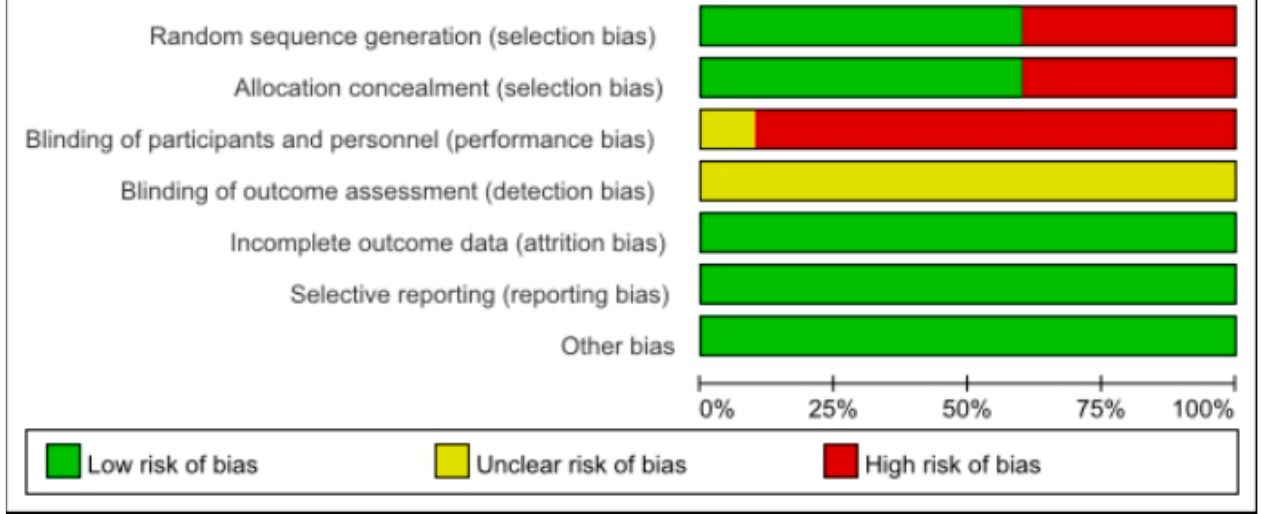
Figure 2. Risk of bias assessment of trials.